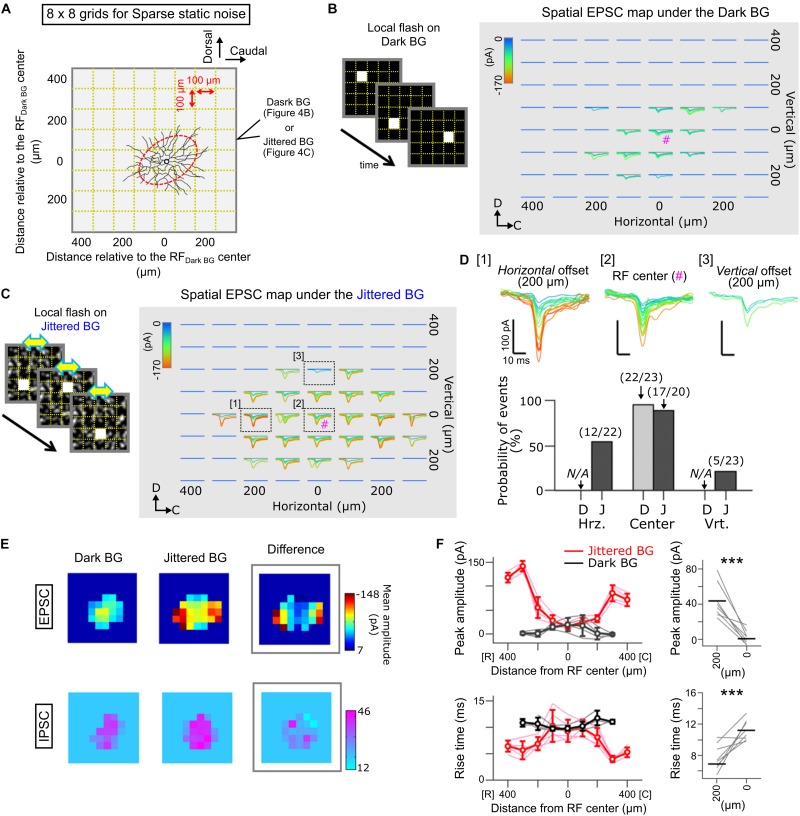
Spatial map of EPSCs evoked by local flash stimulation in Ft GCs. (A) A schematic of sparse noise stimulation on the Dark (B) and Jittered BG (C). The sparse noise was a sequence of a static flash (size, 100 × 100 μm; duration, 50 ms) randomly applied at one of the 8 × 8 grids (gold dotted lines). Stimulus location was described from the RF center estimated under the Dark BG condition (red). (B,C) Superimposed EPSCs evoked by local flash stimulation presented on the Dark (B) and Jittered (C) BGs. EPSCs are colored based on the peak amplitude. #; the RF center. (D) Top, EPSCs evoked at three locations: [1] horizontally 200 μm away from the RF center, [2] the RF center, and [3] vertically 200 μm away from the RF center. Bottom, probability of EPSC events evoked by local flash stimulation. Numbers, EPSC events/stimulation. N/A, no evoked EPSCs. D, Dark BG. J, Jittered BG. (E) Heatmaps showing the peak amplitude of EPSCs (top) and IPSCs (bottom) evoked by local flash stimulation on the Dark (left) and Jittered (center) BGs. Right, a heatmap showing differences of amplitude between the Dark and Jittered BGs. Data from the Ft GC (C). (F) Left, peak amplitude (upper) and rise time (lower) of the evoked EPSCs are plotted against the position relative to the RF center (5 Ft GCs) under the Dark (black) and Jittered (red) BG conditions. Thin lines, data from individual cells. Right, mean peak amplitude (upper) and rise time (lower) of EPSCs evoked by flash stimulation 200 μm away from the RF center and at the RF center (0 μm). ∗∗∗p < 0.001.